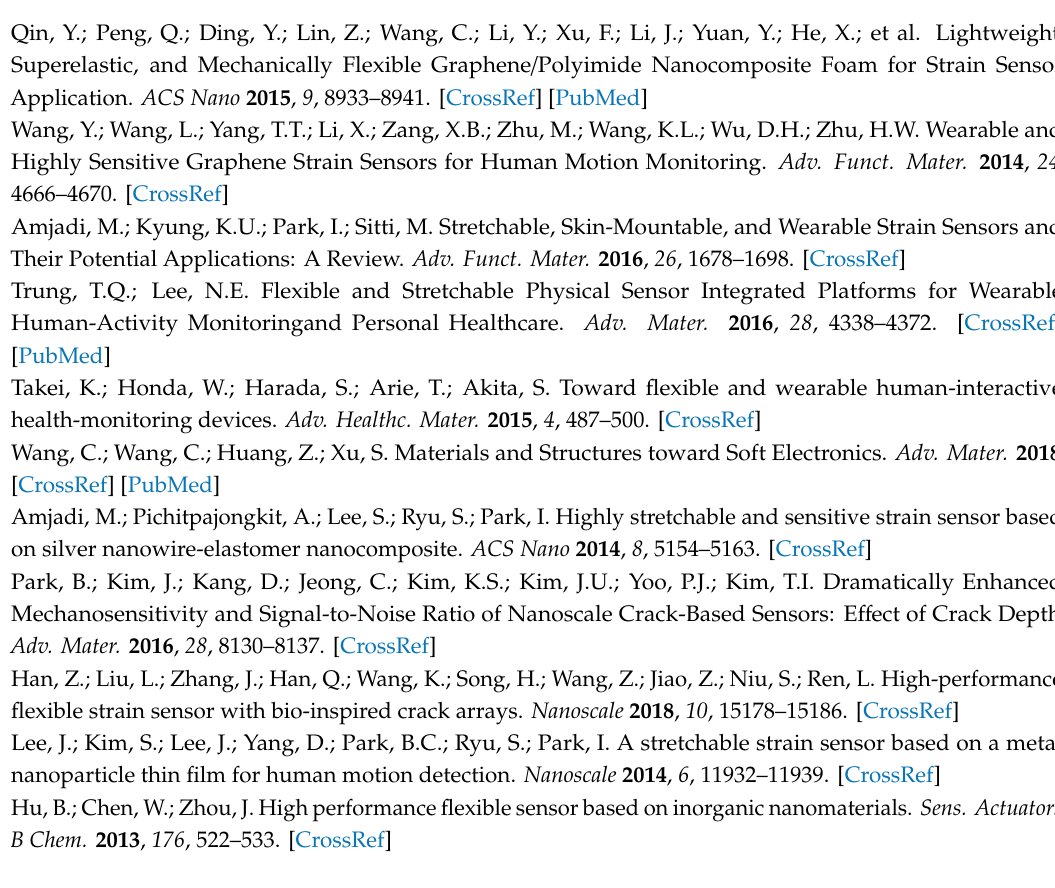
Table S1: GFs at 100% strain of all sensors used to complete all the